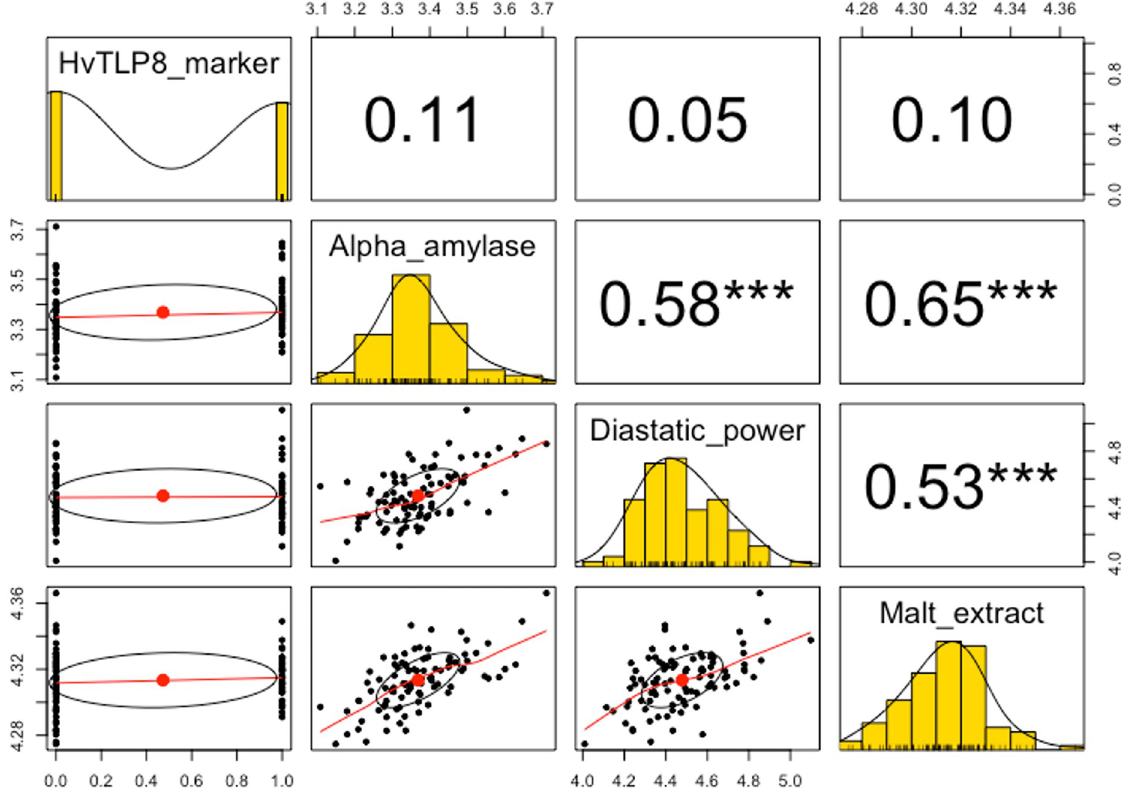
Fig 6. Correlations ( r ) between HvTLP8 and malting quality traits along with the correlation between traits for DH mapping population. The scatter plot matrix (below diagonal), the histogram distributions are in the diagonal, and the correlation values are above diagonal. The ( * ) represents labels of significances ( *** ) shows highly significant correlation ( p < 0.001) and values without asterisks are insignificantly correlated.